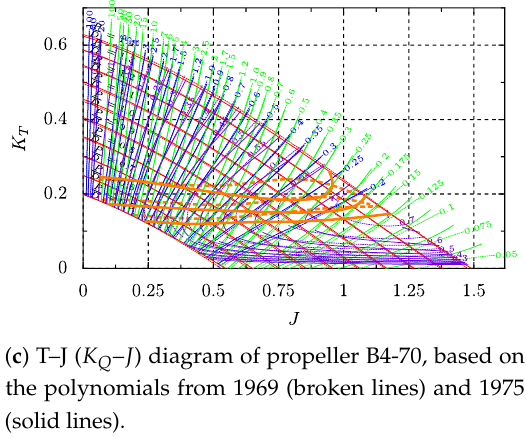
Figure 6. Comparison between the original Danckwardt diagrams, 1956 [6] (probably based on the original data from 1949 [4]); diagrams calculated with polynomials for the scaled and faired open-water characteristics, 1969 [5]; and the most recent polynomials, 1975 [2]. Reproduced from [3], with permission from AMT’17,